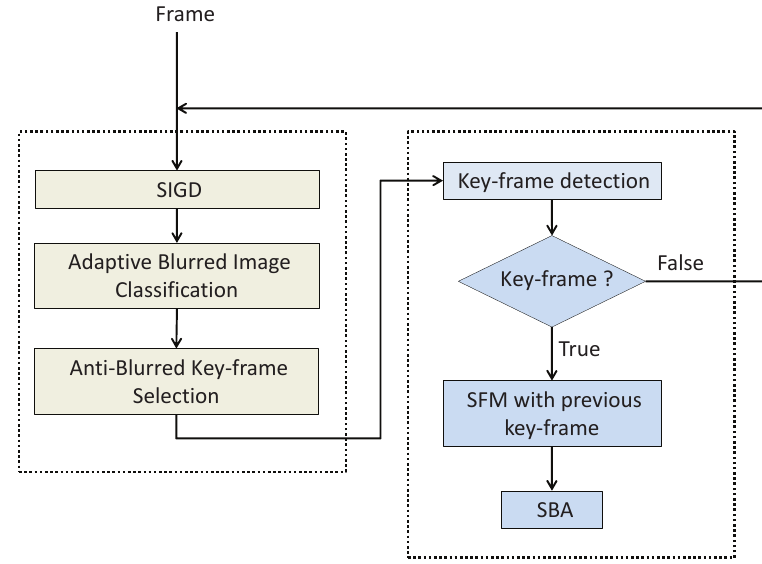
Figure 1. Framework of our robust visual odometry anti-blurred image. The left box is our framework, and the right box is a typical pipeline for the VO, and the output of our framework can be easily regarded as the input of the VO algorithms. Here SFM is the abbreviation of Structure From Motion [17], and SBA is the abbreviation of Sparse Bundle